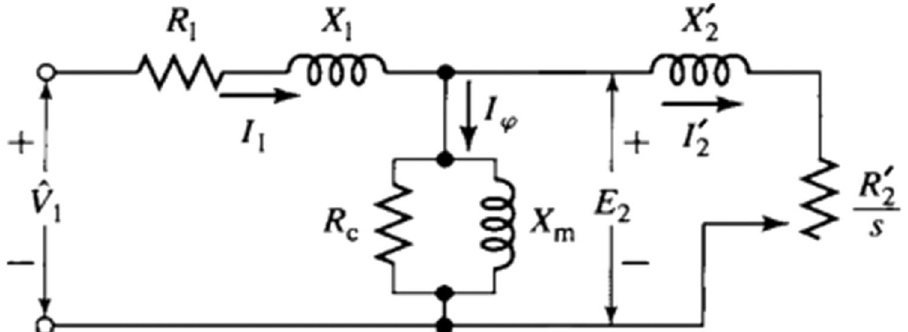
Fig. 1 Per-phase equivalent circuit of a 3-phase Induction